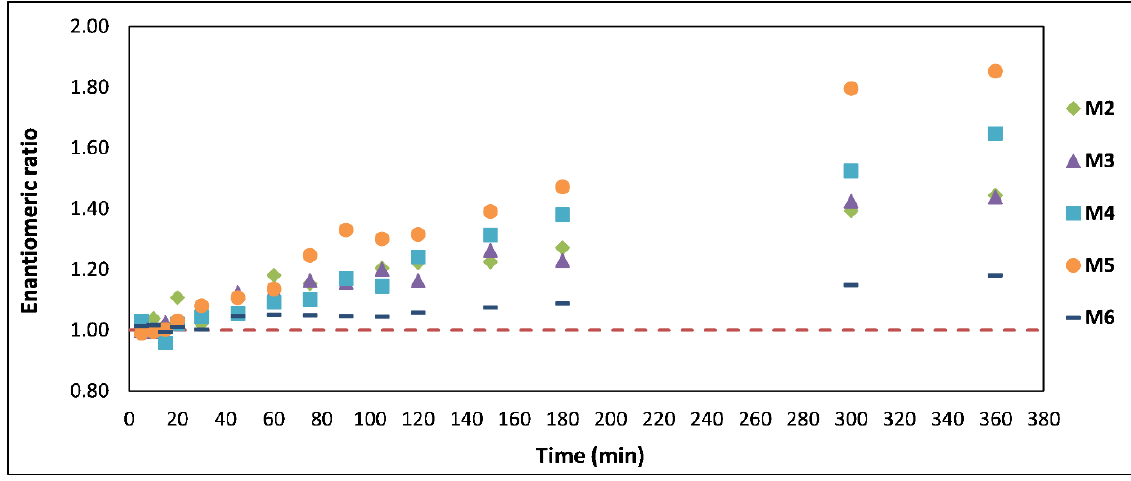
Figure 4. Changes in the enantiomeric ratio over time post mephedrone administration in M2–M6; the dashed line at 1.0 shows the expected enantiomeric ratio if both enantiomers were present in whole blood samples at 1:1 ratio.